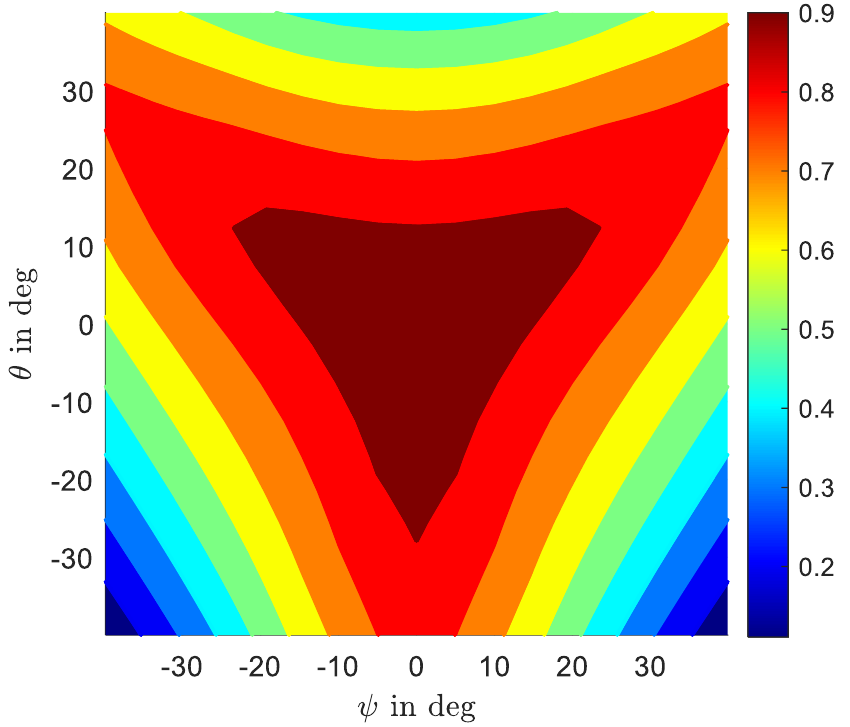
Figure 11. Manipulablity of the design shown in Figure 10 when v x = v y =